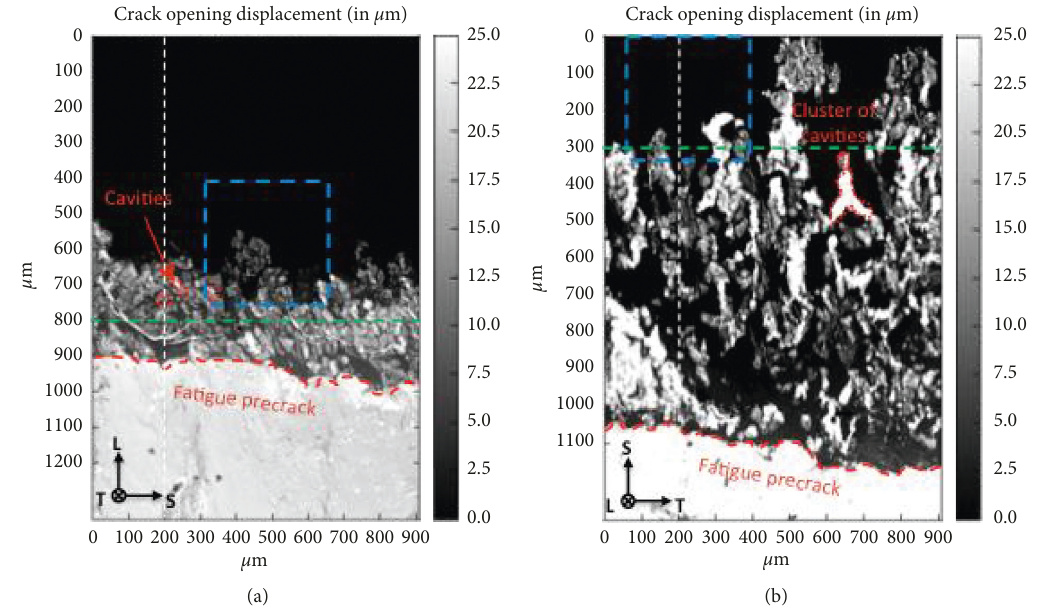
Figure 8: Representation of the local crack tip opening via a “sum along ray method” for (a) TL and (b) LS configurations (with lines indicating locations of the 2D